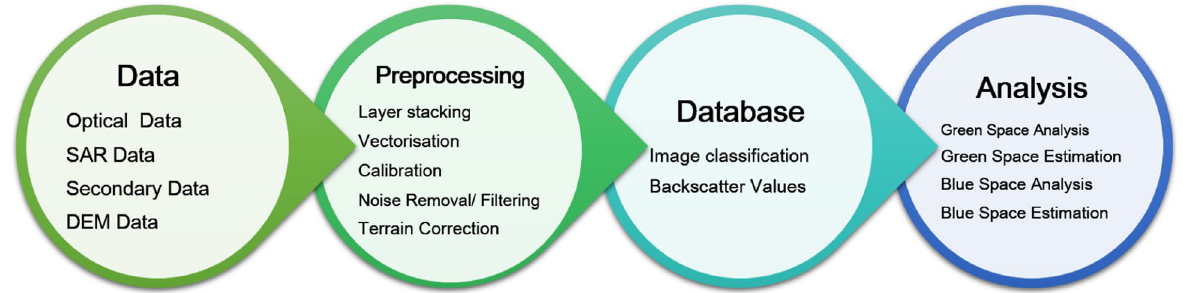
Fig. 3 A comprehensive approach to the assessment of green and blue spaces